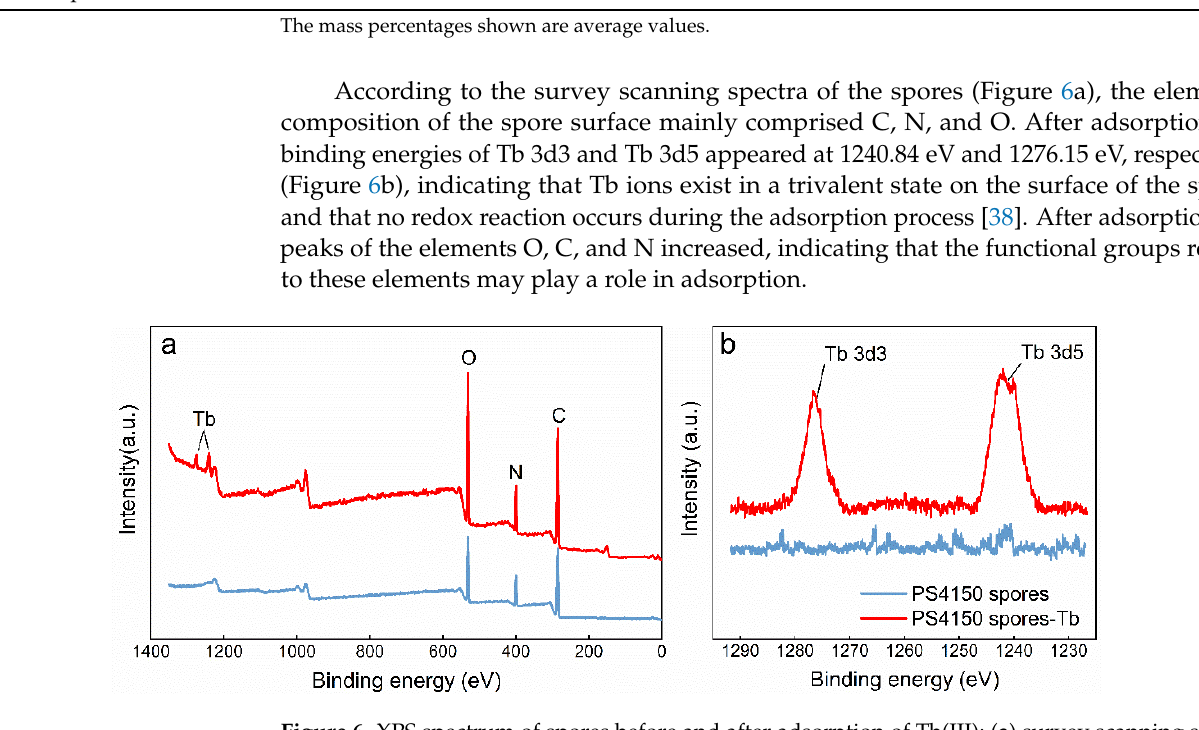
Table 3. Elemental mass percentage of B. subtilis spores before and after the adsorption of Tb(III). Elemental Mass Percentage (%) Different Biosorbents C PS533 spores PS533 spores-Tb PS4150 spores PS4150 spores-Tb The mass percentages shown are average values.